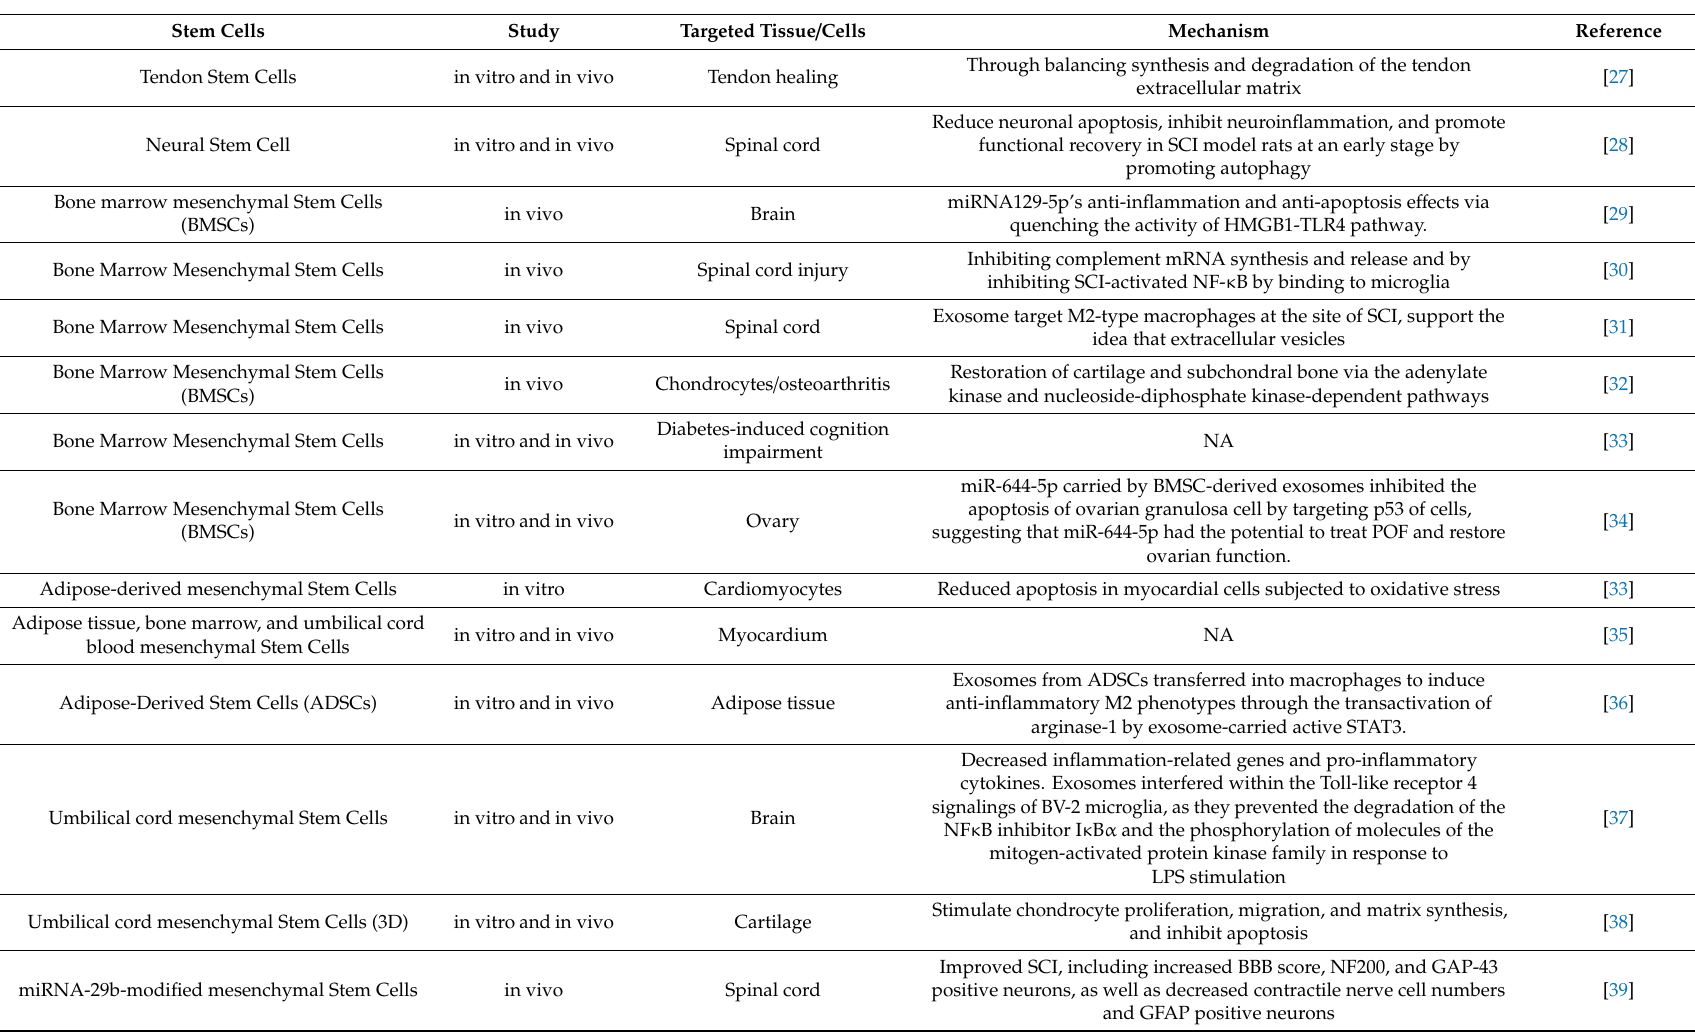
Table 1. A summary of some therapeutic applications of Mesenchymal stem cells (MSC)-derived exosomes and other extracellular vesicles in di ff erent